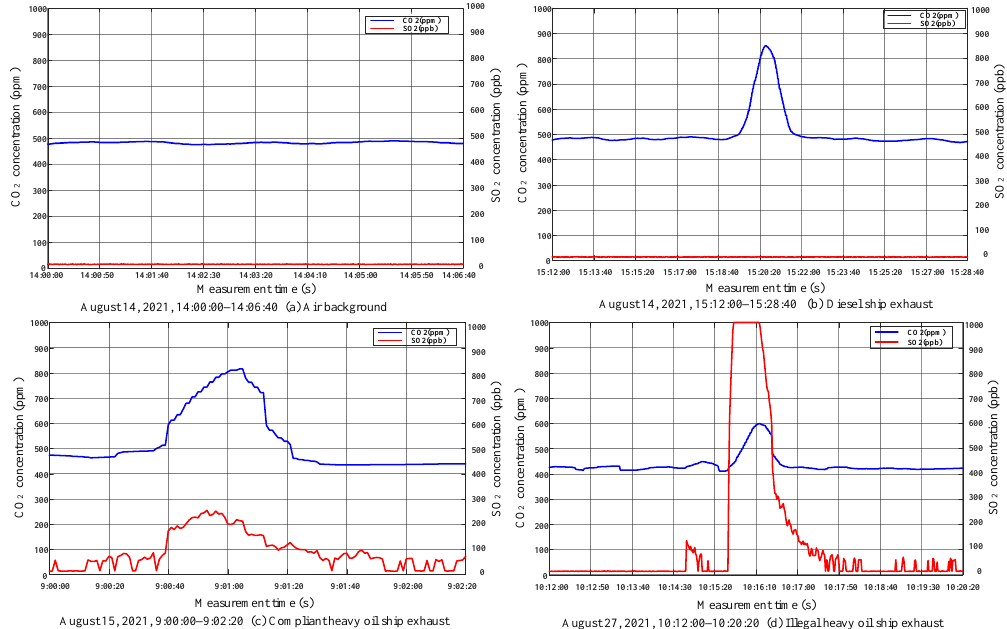
Figure 6. Monitoring curve of sulfur content in different fuel. The test results show that when the increase in SO 2 concentration in tail gas exceeds three times that of CO 2 concentration, it can be considered that the FSC of the ship exceeds the standard. Figure 7 shows the actual monitoring curves of tail gas of the eight groups of high sulfur oil ships. The X-axis and Y-axis of the curve represent time and gas concen- tration, respectively, the red curve represents SO 2 concentration (ppb), and the blue curve represents CO 2 concentration (ppm). From Figure 7a–h, it can be seen that the